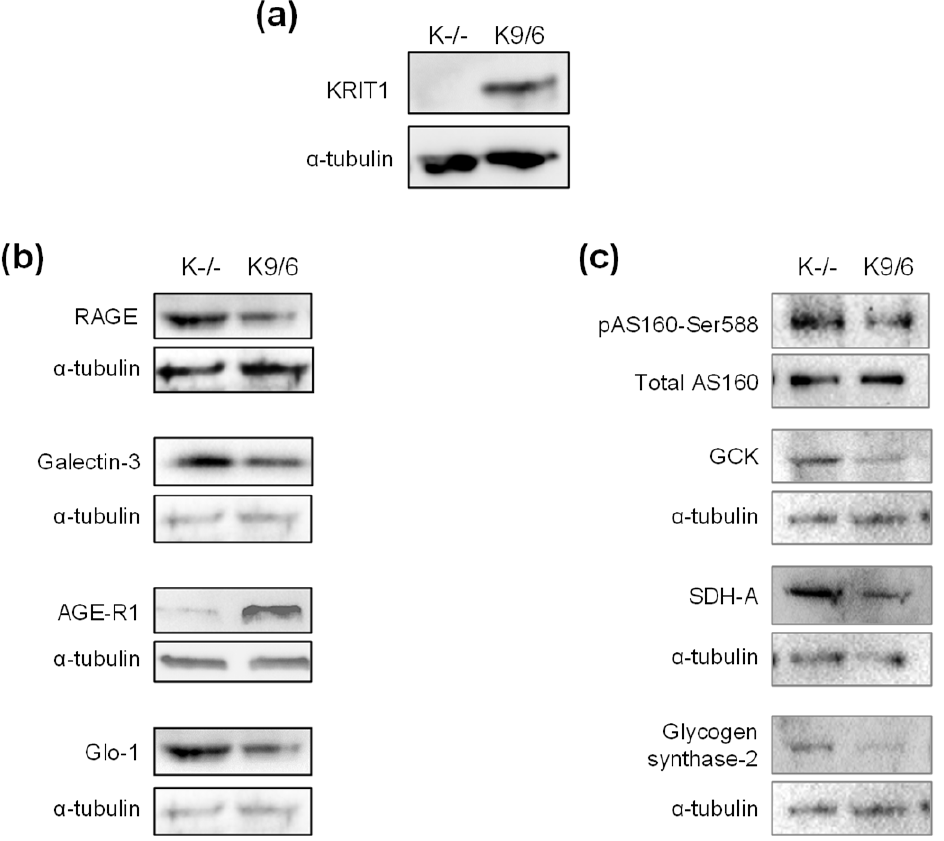
Figure 7. Alterations in AGE receptors and regulatory proteins of glucose metabolism detected in the liver of KRIT1 +/− mice were recapitulated in KRIT1 knockout cellular models. ( a ) Representative Western blot of KRIT1 protein expression in KRIT1 knockout (K-/-) and KRIT1 re-expressing (K9/6) MEF cells. ( b ) Representative Western blots showing the upregulation of receptor for AGE (RAGE) and galectin-3 (Gal-3), the downregulation of AGE-receptor-1 (AGE-R1), and the upregulation of glyoxalase-1 (Glo-1) expression levels in KRIT1 knockout (K-/-) vs. KRIT1 re-expressing (K9/6) MEF cells. ( c ) Representative Western blots showing the upregulation of markers of glucose uptake [phosphorylated Akt substrate of 160 kDa (pAS160-Ser588)], glycolysis [glucokinase (GCK)], mitochondrial energy metabolism [succinate dehydrogenase A (SDH-A)], and glycogen synthesis (glycogen synthase-2) in KRIT1 knockout (K-/-) vs. KRIT1 re-expressing (K9/6) MEF cells. The level of α -tubulin has been used as loading control. Data are representative of 4 independent experiments. 3. Discussion The KRIT1 gene is widely expressed in human and mouse tissues, including in the nervous system, the thymus, the epidermal, digestive, respiratory, uterine and urinary epithelia, and ossification centers, indicating a widespread functional significance, not restricted to the cerebrovascular system [26 – 28]. However, extracerebral phenotypes of KRIT1 loss-of-function mutations have been poorly investigated in in vivo models. Recently, we reported that heterozygous KRIT1 knockout (KRIT1 +/− ) mice exposed to a high-fructose diet, known to induce systemic oxidative stress and inflammation, had an approximately 2-fold enhanced fat accumulation in the aortic arch and aortic root, as compared to corresponding wild-type (WT) littermates fed the same high-fructose diet, suggesting that KRIT1 may be implicated in intermediary metabolism – redox circuits underlying atherosclerosis development [25]. In the present study, we demonstrate, for the first time, that heterozygous loss of KRIT1 in mice has a major impact on the liver, causing significant alterations in its